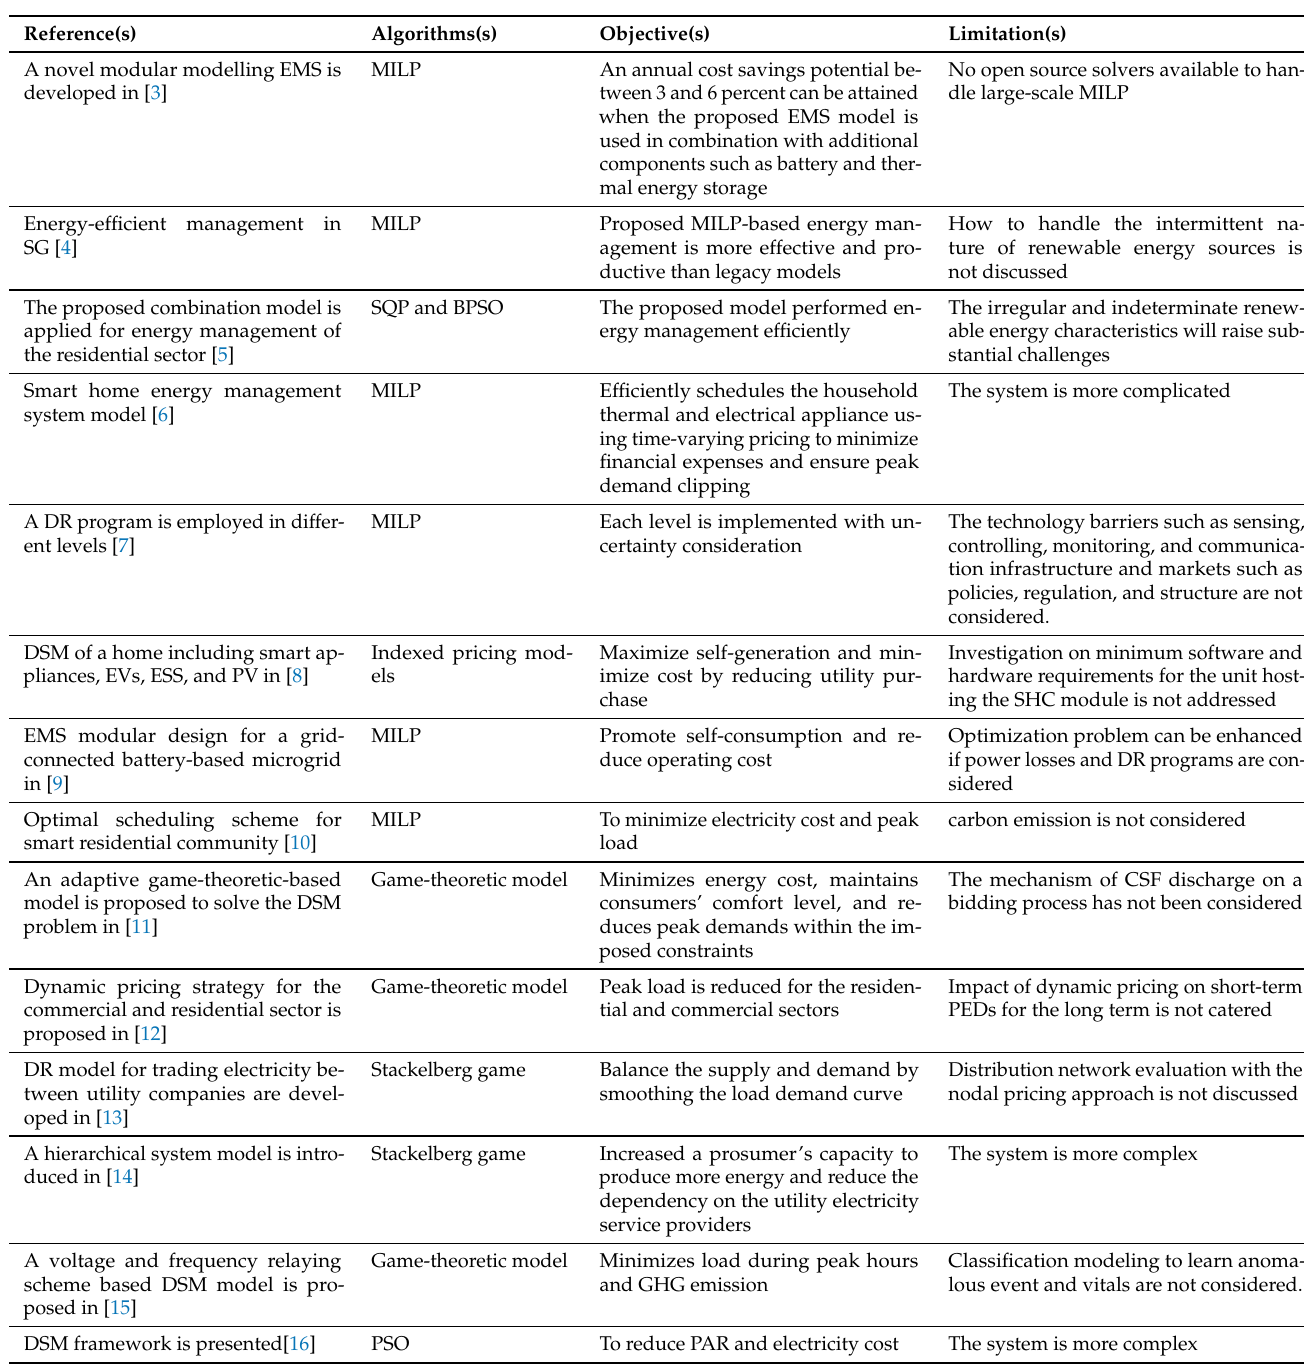
Table 1. A comprehensive review of the latest literature in terms of proposed algorithms, objectives, and